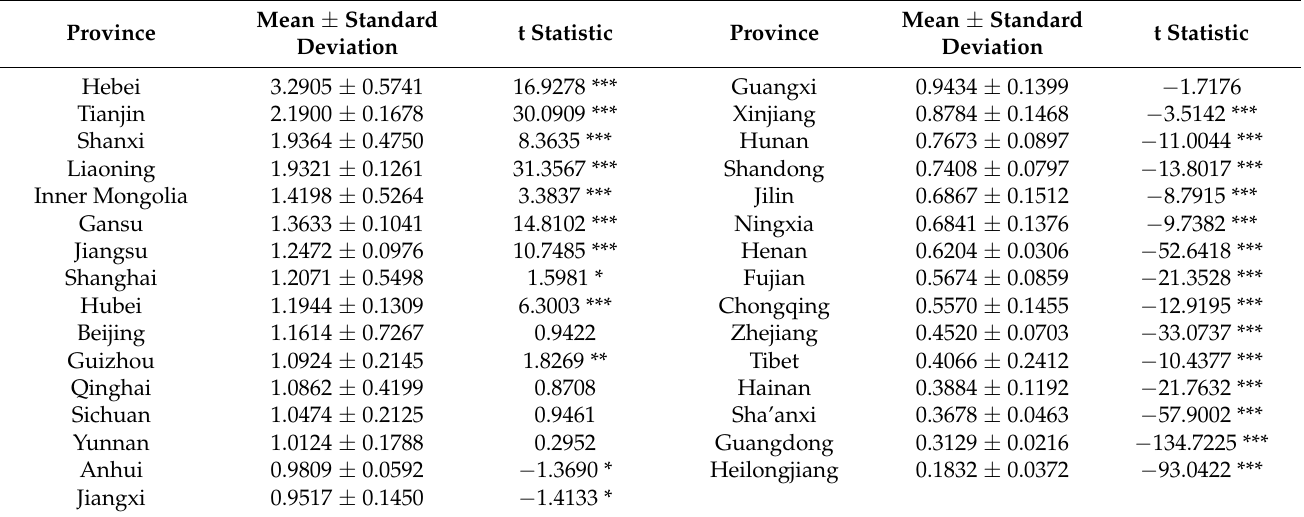
Table 1. Statistical table of location entropy of each province in